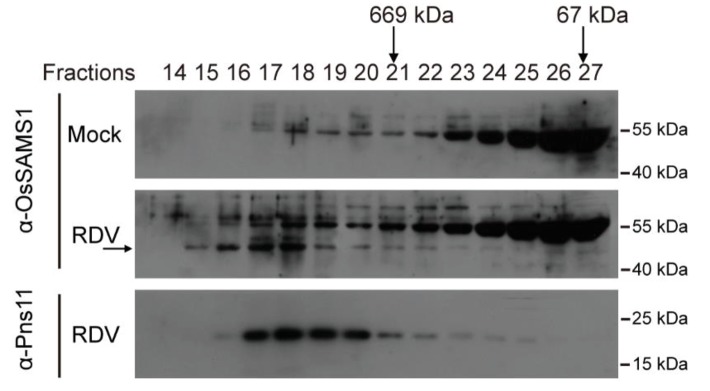
Gel-filtration analysis of Pns11 and OsSAMS1.Gel filtration analysis of Pns11 and OsSAMS1. The high-molecular-weight fraction peak of Pns11 and OsSAMS1 is indicated. The two vertical black arrows indicate fractions in which the 669-kDa and 67-kDa protein standards eluted. The horizontal black arrows indicate the location of OsSAMS1. Tissues were collected at 4 wpi.